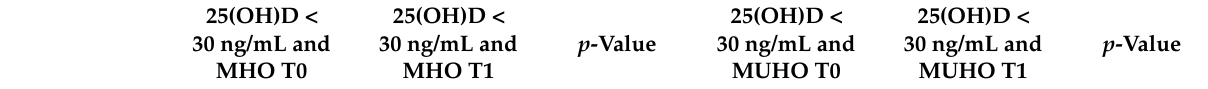
Table 2. Mean or percentage of inadequacy of body and biochemical variables, and presence of chronic noncommunicable diseases considering 25(OH)D < 30 ng/mL together with different metabolic phenotypes before and after Roux-en-Y Gastric Bypass bariatric surgery.